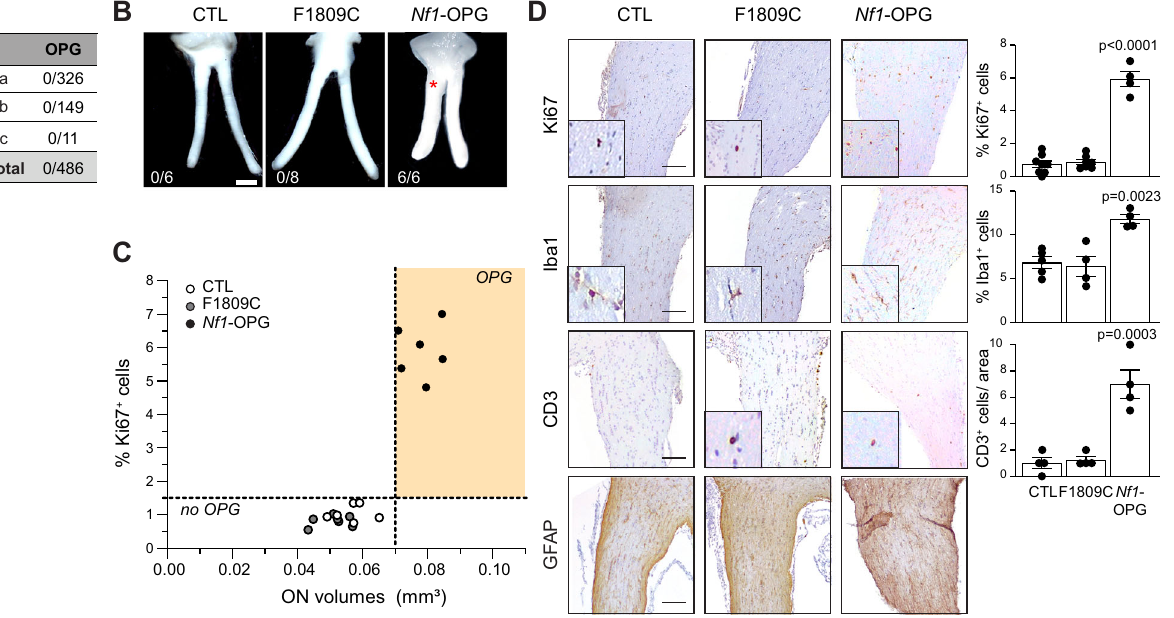
Fig. 1 Arg1809Cys Nf1- mutant mice do not develop optic gliomas following somatic Nf1 inactivation. A Incidence of optic pathway glioma (OPG) in NF1 patients harboring the c.5425C> T NF1 germline mutation. (a) 44 , (b) 45 , (c) 40 . B Representative images of dissected optic nerves from control ( Nf1 f/f ; CTL) and Nf1- mutant mice harboring conditional somatic Nf1 inactivation in neuroglial progenitors ( Nf1 f/1809 ; GFAP- Cre, F1809C; Nf1 f/neo ; GFAP -Cre, Nf1 -OPG). Whereas Nf1 -OPG mice form OPGs (red asterisk), CTL and F1809C mice do not. The number of mice that formed OPGs is shown in each panel. Scale bar: 1 mm. C Graph demonstrating the relationship between optic nerve volumes and Ki67 + cells in CTL, F1809C, and Nf1 -OPG optic nerves. n = 6 for all groups. D Ki67, Iba1, CD3, and GFAP immunostaining of optic nerves in CTL, F1809C, and Nf1 -OPG mice. Scale bars, 50 µ m. (Ki67: CTL n = 8, F1809C n = 7, Nf1 -OPG n = 4, P < 0.0001; Iba1: CTL n = 5, F1809C n = 4, Nf1 -OPG n = 4, P = 0.0023; CD3: CTL n = 4, F1809C n = 4, Nf1 -OPG n = 4, P = 0.0003). Data are represented as means ± SEM. One-way ANOVA with Dunnett ’ s post-test correction. P values are indicated within each panel. ns, not signi fi cant. Source data are provided as a Source Data fi